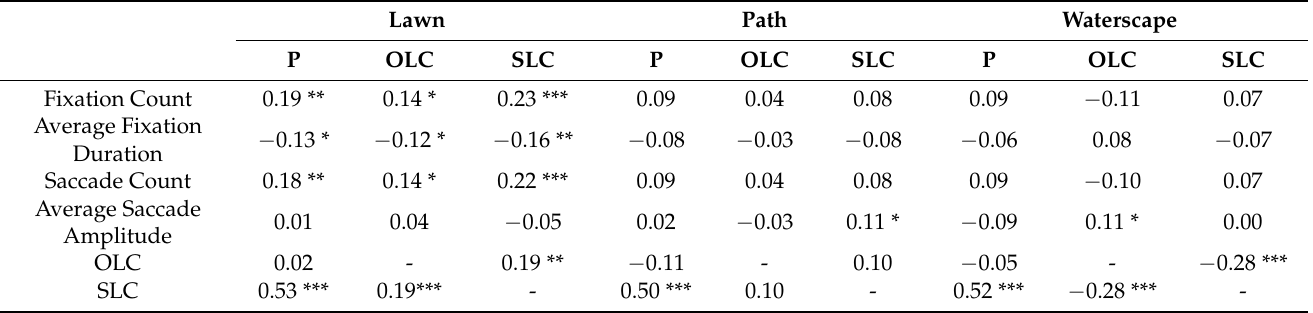
Table 4. Correlations among eye movement parameters, preference